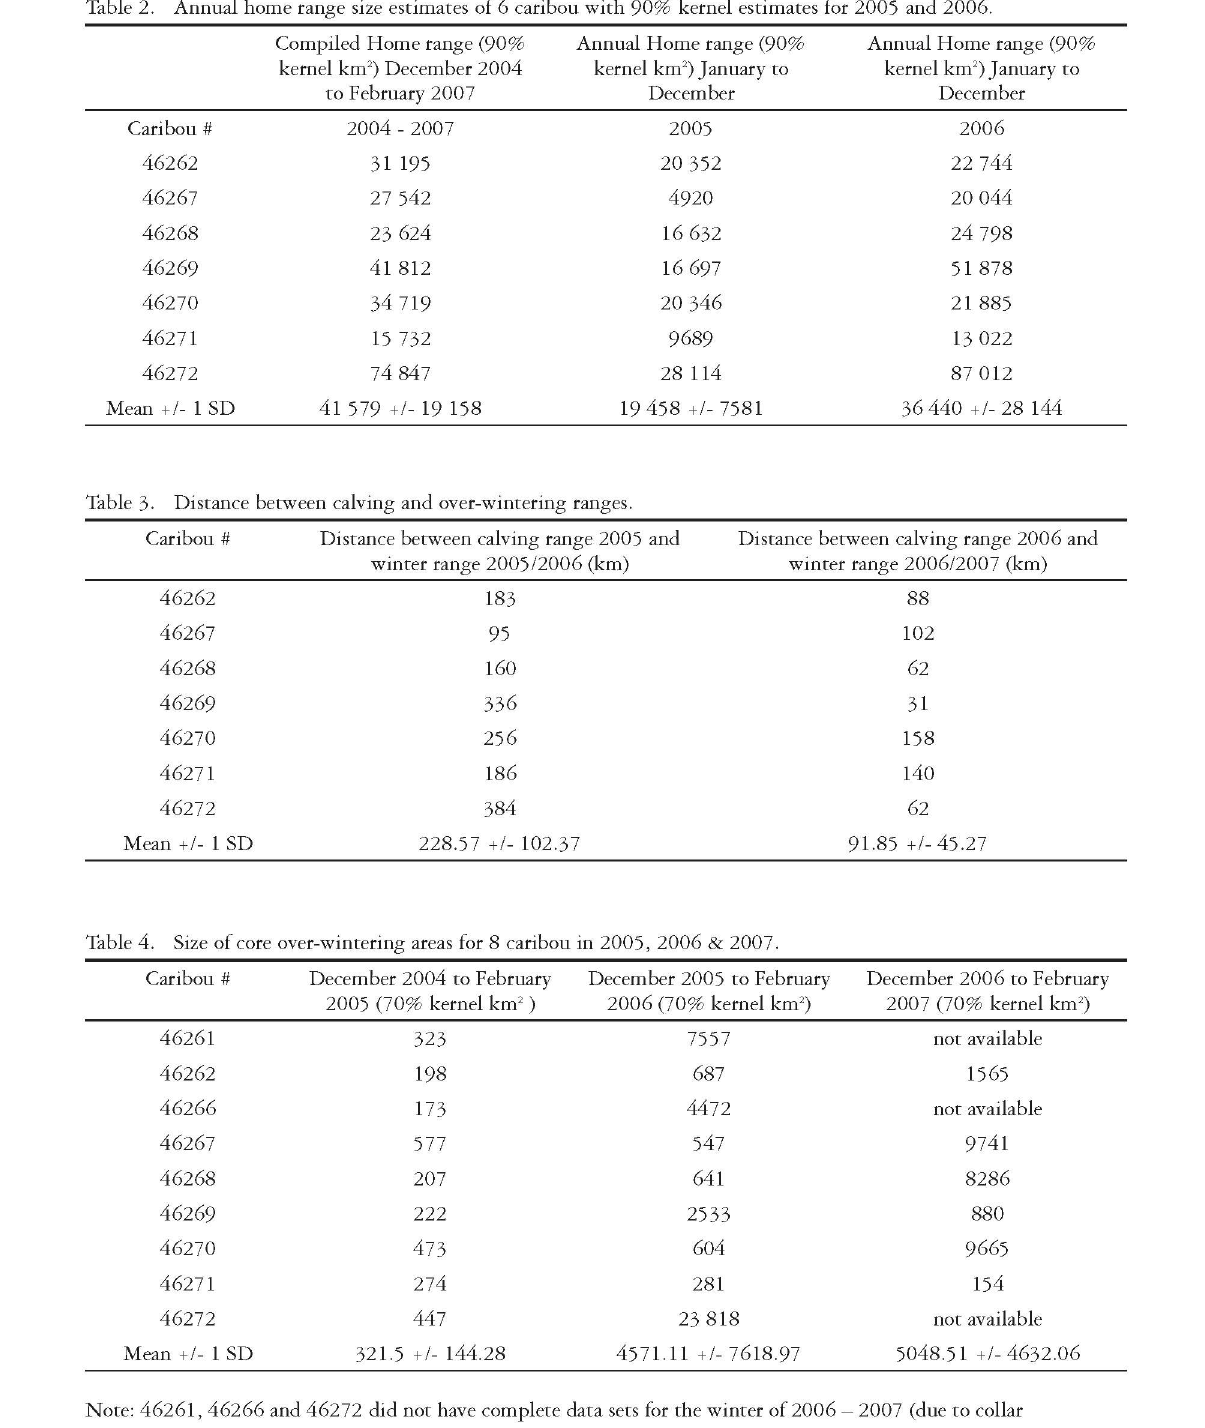
Table 2. Annual home range size estimates of 6 caribou with 90% kernel estimates for 2005 and 2006.